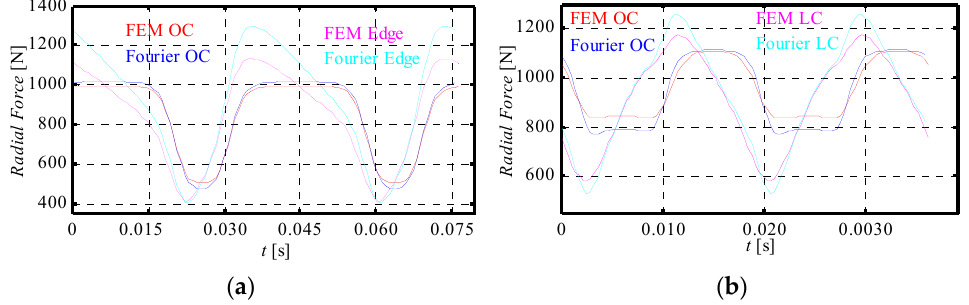
Figure 20. Forces created on a tooth base in open-circuit and load conditions: ( a ) Qs48p8, ( b ) Qs36p15.